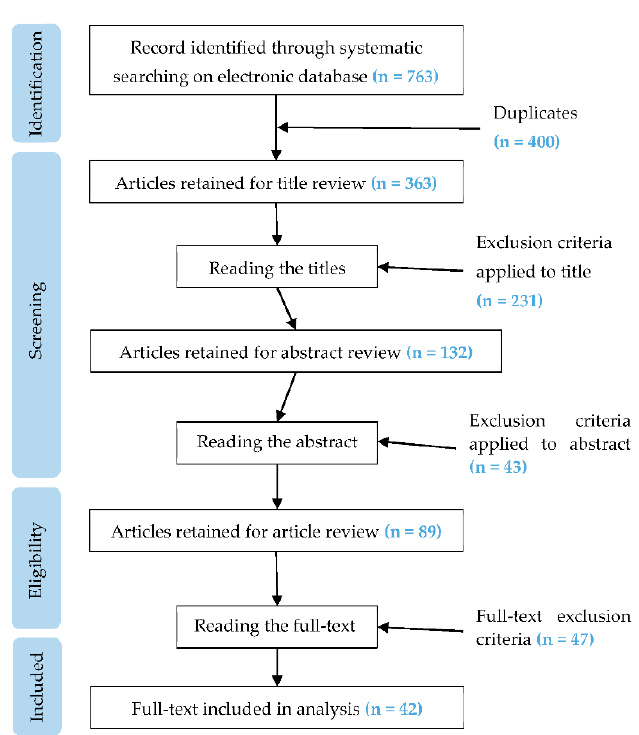
Figure 1. Flow diagram outlining the search and study selection process.